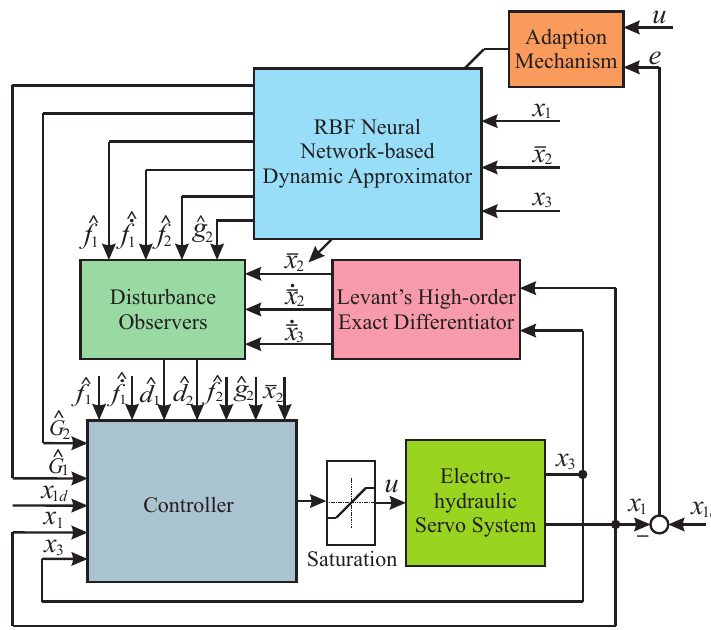
Figure 2. The control scheme of the proposed control